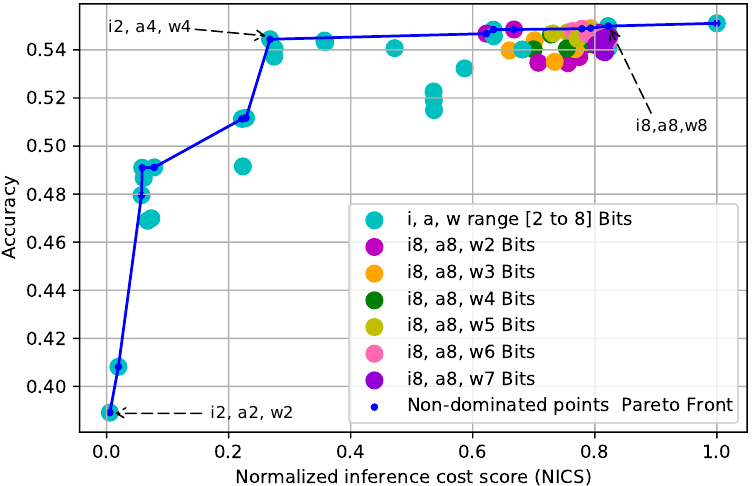
Figure 4. Effect of quantization in the VGG10 1D-CNN architecture regarding the accuracy and inference cost. Inputs, activations, and weights are quantized in a range of 2 to 8 bits in the first stage (in aquamarine). Points in different colors represent the degree of quantization in the weights (see the second-stage methodology). In blue, the points with the best solutions obtained thus far with the Pareto front are highlighted.